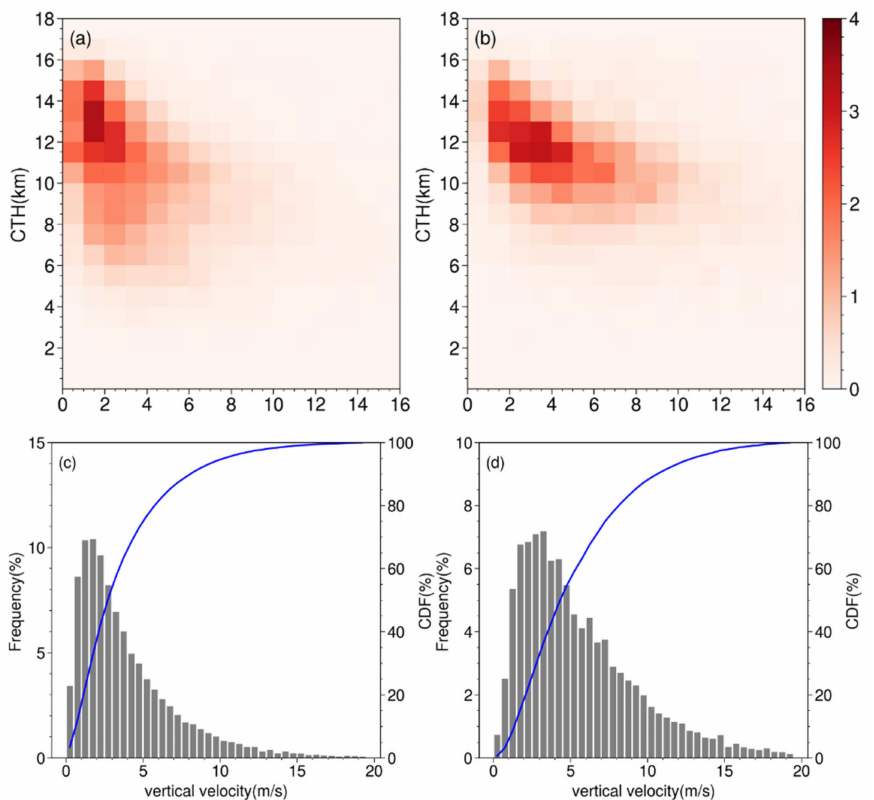
Figure 3. ( a , b ) Frequency distribution of convective cloud top vertical velocity (w) at different cloud top heights; ( c , d ) Frequency (grey bar) and cumulative distribution function (CDF) (blue line) of the cloud top vertical velocity at all levels. The panels are over land (left column) and ocean (right column),